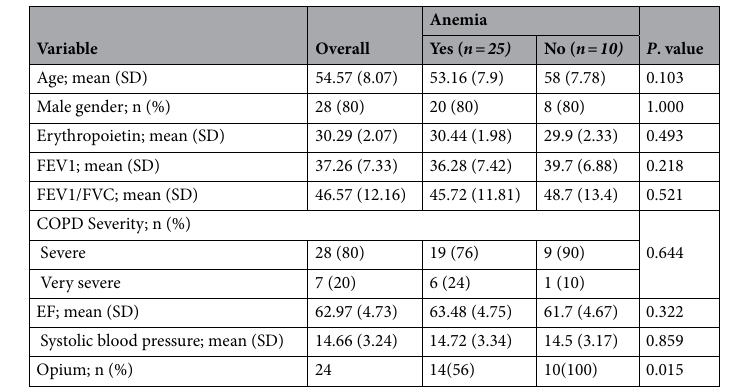
Table 2. Evaluation anemia among clinical features of COPD patients. SD standard deviation, FEV1 forced expiratory volume in one second, FVS forced vital capacity, COPD chronic obstructive pulmonary disease, EF ejection